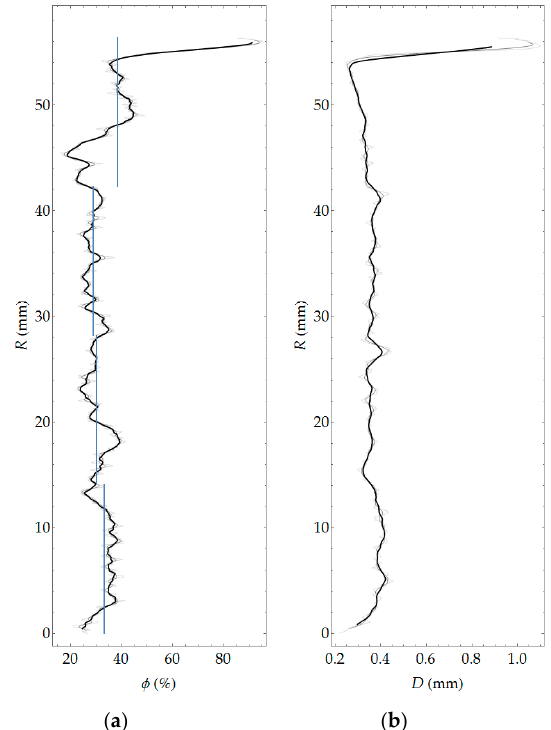
Figure 14. Volume fraction ( a ) and average local thickness ( b ) of cement matrix as a function of the element thickness.